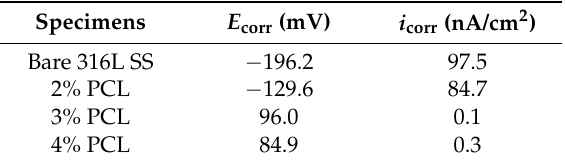
Figure 3. The cathodic and anodic polarization Tafel curves of the bare 316L SS and the 316L SS coated with 2, 3, and 4% PCL films. Table 1. The average E corr and i corr values determined according to the cathodic and anodic polarization Tafel curves in Figure